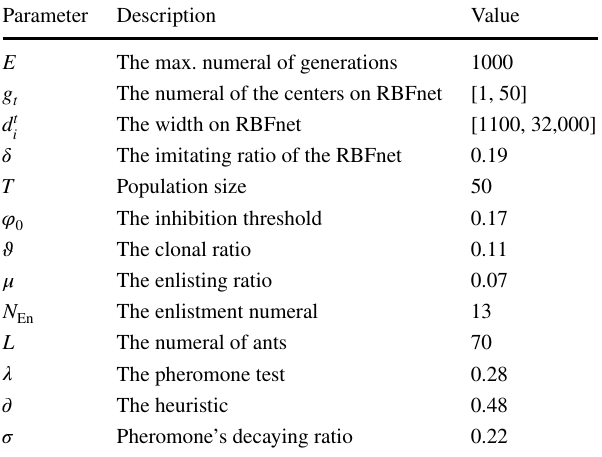
Table 2 Parameter values for the HIAO algorithm Parameter